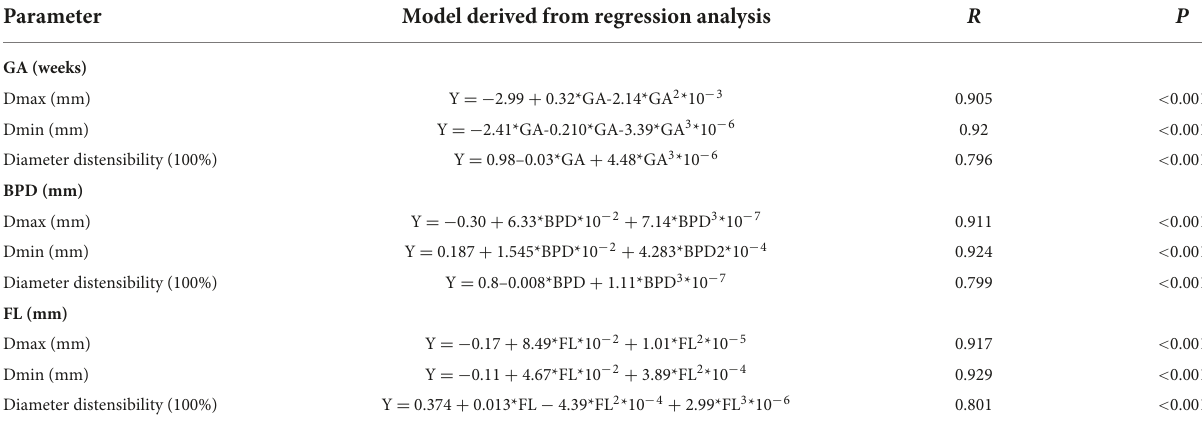
TABLE 2 Regression models for the prediction of the mean of Dmax, Dmin, and diameter distensibility based on GA, BPD, and FL. Parameter Model derived from regression analysis R P